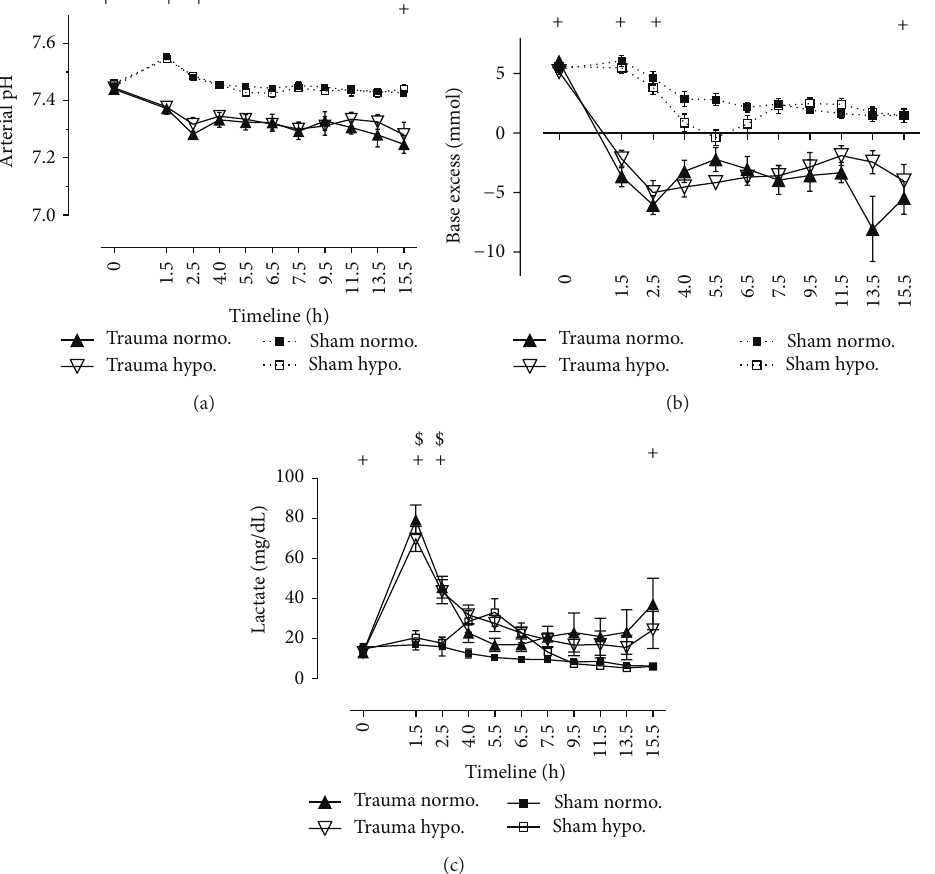
Figure 3: Blood gases and respiratory parameters. Normothermic and hypothermic sham animals versus normothermic and hypothermic trauma animals. 𝑁 = 40 . Timeline 15.5 hrs. Data are shown in mean and standard error of mean. + 𝑃 < 0.05 , values at BL versus values at S and at R and values at E of trauma pigs (0, 1.5, 2.5, and 15.5 hrs). $ 𝑃 < 0.05 , values at S versus values at R in trauma pigs (1.5 and 2.5 hrs). § 𝑃 < 0.05 , values at R versus values at H in trauma pigs (2.5 and 4.0 hrs). (a) Arterial pH. (b) Base excess (BE in mmol/L). (c) Lactate in mg/dL.